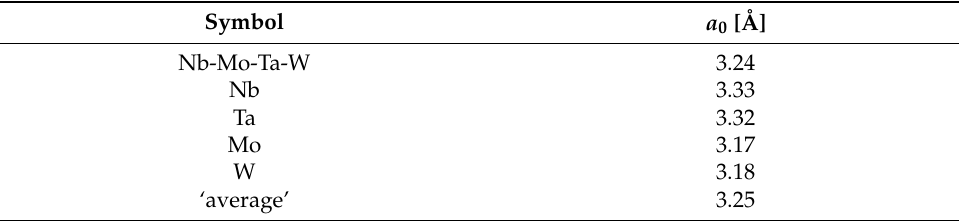
Figure 1. Potential energy per atom as a function of a for random equiatomic Nb-Mo-Ta-W. Table 1. Simulated equilibrium lattice parameters of the random equiatomic Nb-Mo-Ta-W alloy, the ’average’ alloy and the individual constituents